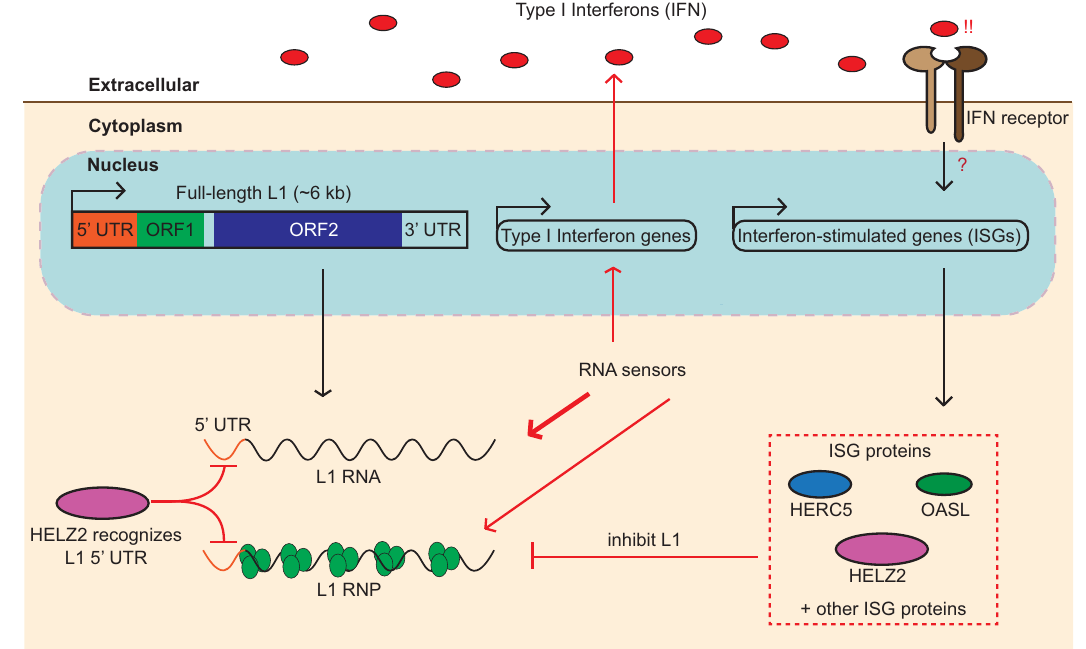
Fig. 7 | A working model hypothesizing a negative feedback loop between L1 RNAlevelsandISGproteins. L1RNAsand/orRNPscanbedetectedbycytoplasmic RNA sensors, which elicit the secretion of type I interferons (IFNs); ORF1p RNAbindingmightshieldL1RNAfromthesensors.IFN-bindingtotheextracellular IFN cell surface receptors then activates a signaling cascade, which induces